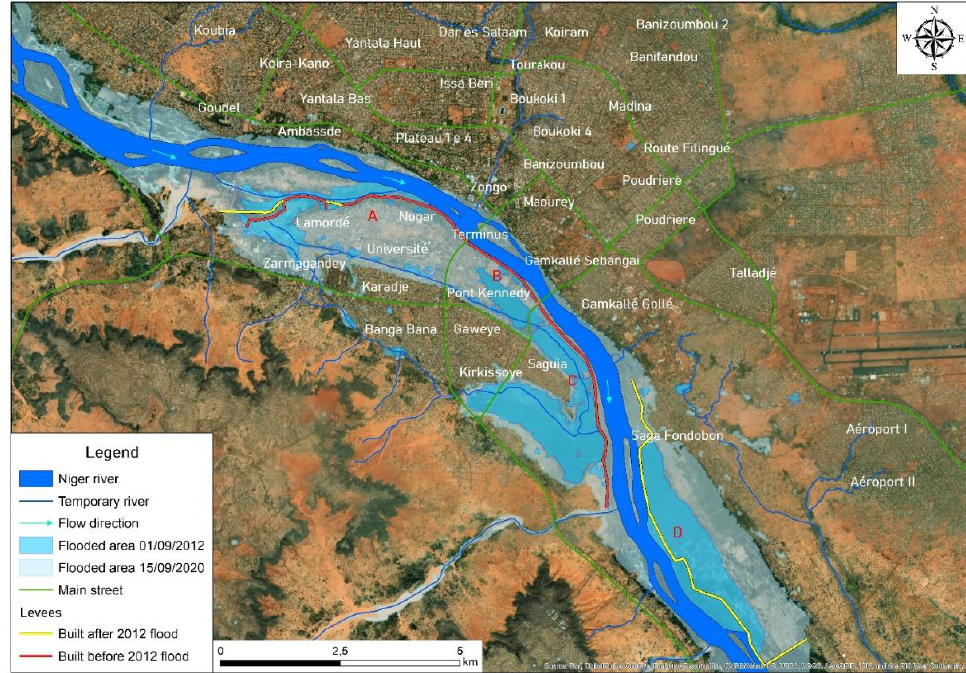
Figure 19. Comparison of Niamey flooded areas in 2012 and 2020 events. The red letters identify the four levee sectors: ( A ) Lamordé, ( B ) bridges, ( C ) Kirkissoye-Saguia and ( D ) Saga.